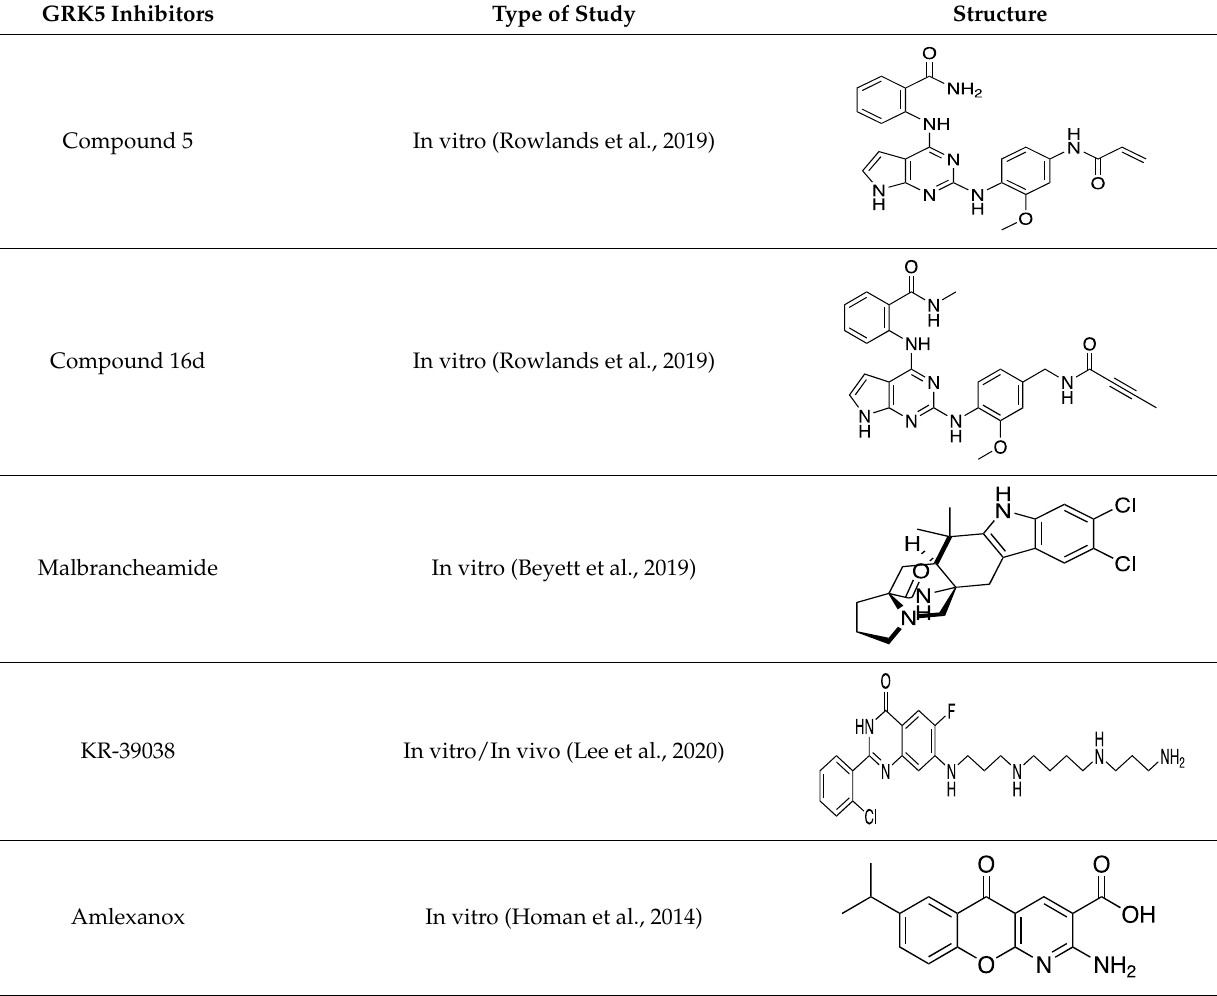
Table 1. Summarizing known GRK5 inhibitors, including the type of pre-clinical studies and their structures. The chemical structures were produced on ChemDraw (accessed on 14 February 2021). GRK5 Inhibitors Type of Study